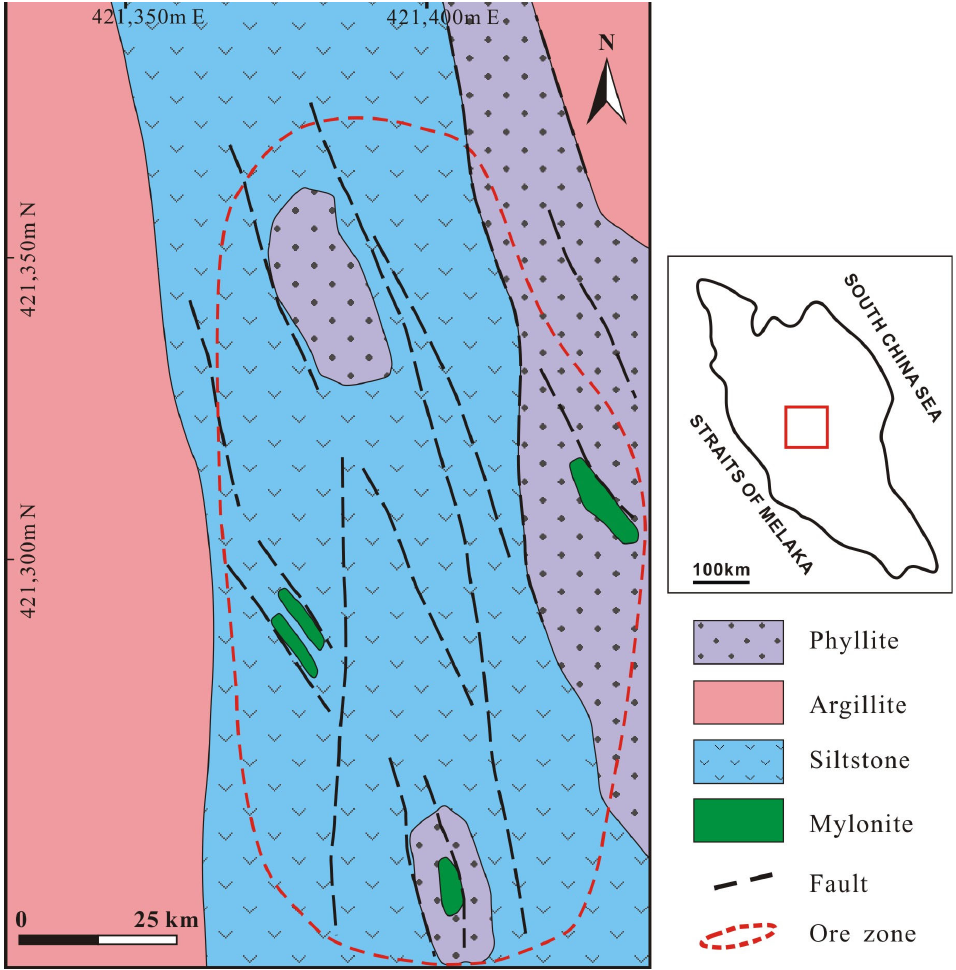
Figure 3. Geological map of the Selinsing gold deposit (Modified from